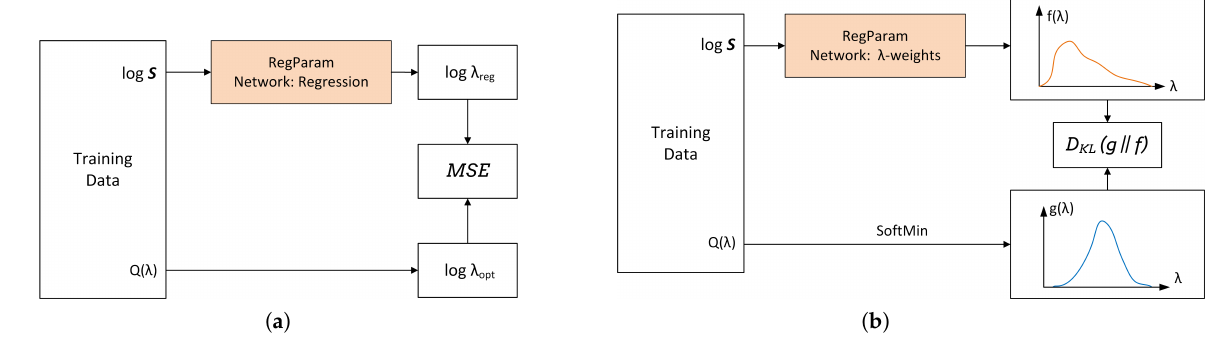
Figure 8. RegParamNet training: ( a ) Direct λ regression; ( b ) g ( λ ) approximation (“ λ